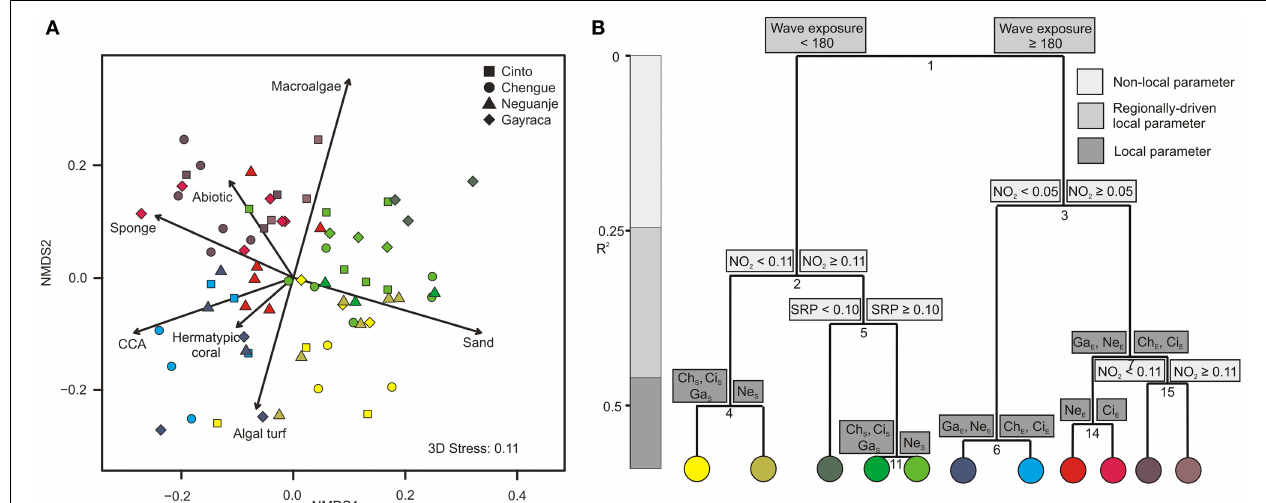
FIGURE 3 | Graphical representation of (A) non-metric multidimensional scaling (NMDS) and (B) multivariate regression tree analysis (MRT) for major benthic groups in Tayrona National Natural Park. (A) Variation in benthic community structure shown for the first two axes from a NMDS and the relative contribution of each benthic group (arrows). Colors indicate groupings according to the coloring of MRT leafs. (B) MRT and associated physical and environmental variable thresholds related to the separation of